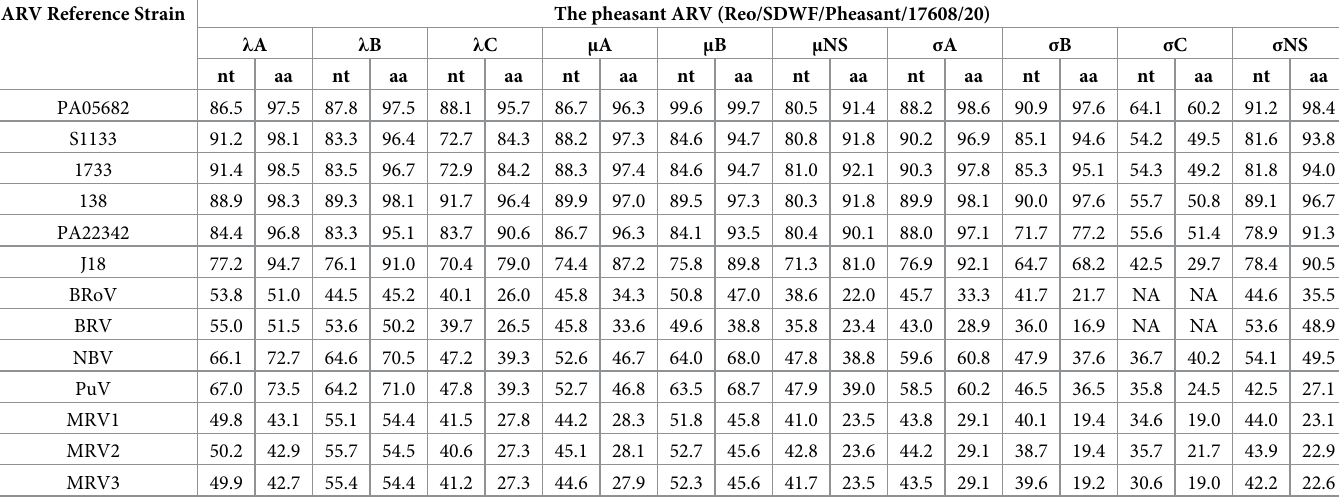
Table 2. Sequence identities between the pheasant ARV (Reo/SDWF/Pheasant/17608/20) and reference strains of Orthoreovirus genus members. ARV Reference Strain The pheasant ARV (Reo/SDWF/Pheasant/17608/20)